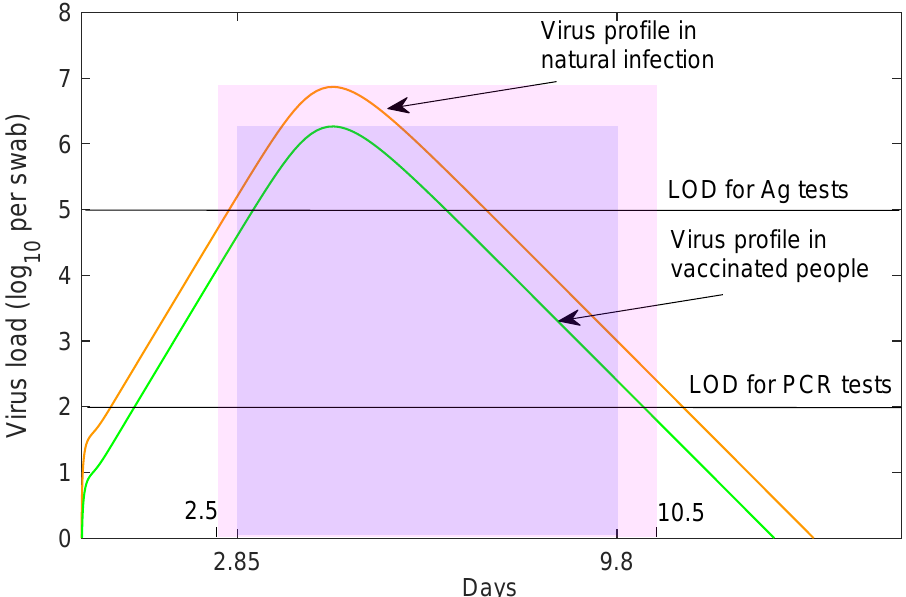
Figure 1. Virus profiles in non-vaccinated and vaccinated individuals. log virus load per swab over 10 time during Alpha variant natural infection (red line) and vaccination (green line) as given by the within-host model in [29]. Non-vaccinated patients are assumed to be infectious from t = 2.5 days till t = 10.5 days (shaded pink region). Vaccinated patients are assumed to be infectious from t = 2.85 days till t = 9.8 days (shaded purple region). Black horizontal lines correspond to RT-PCR ( V ) = 2 per swab and antigen test detection threshold (LOD) test detection threshold (LOD) of log 10 ( V ) = 5 per of log 10